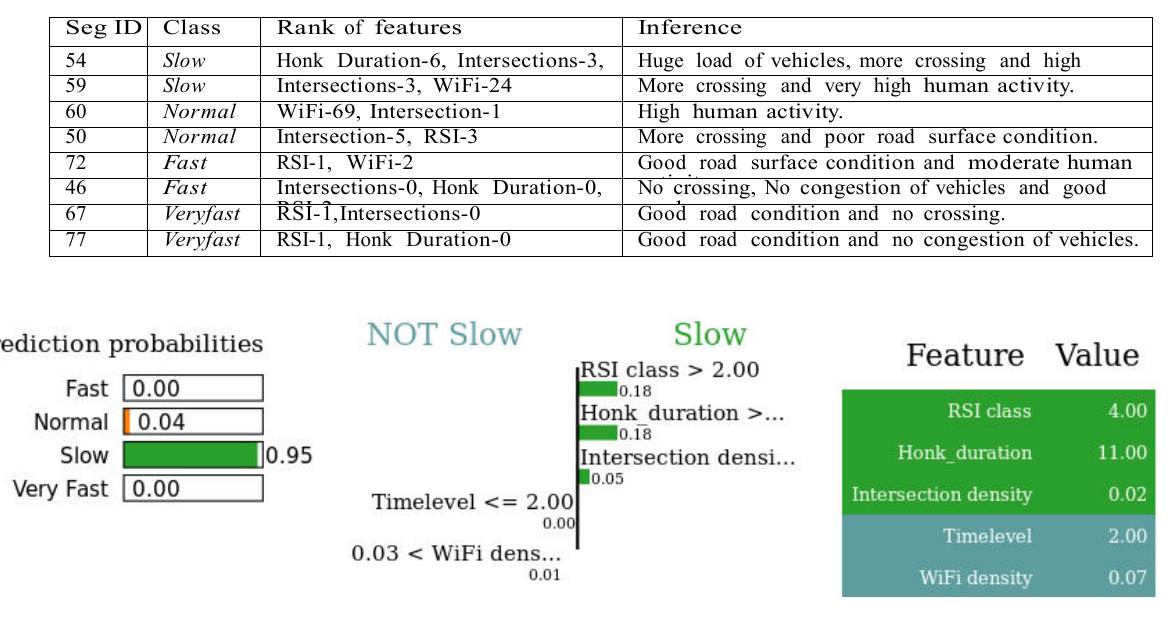
Table 13. Understanding Model Behavior by LIME.